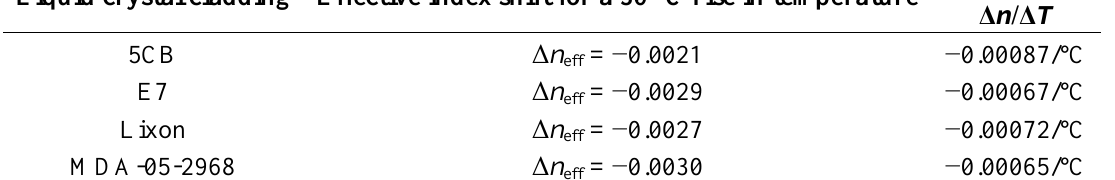
Table 3. Change in the effective index as a function of a 30 °C increase in temperature and the corresponding thermo-optic coefficient of the liquid crystal mixture at 1550